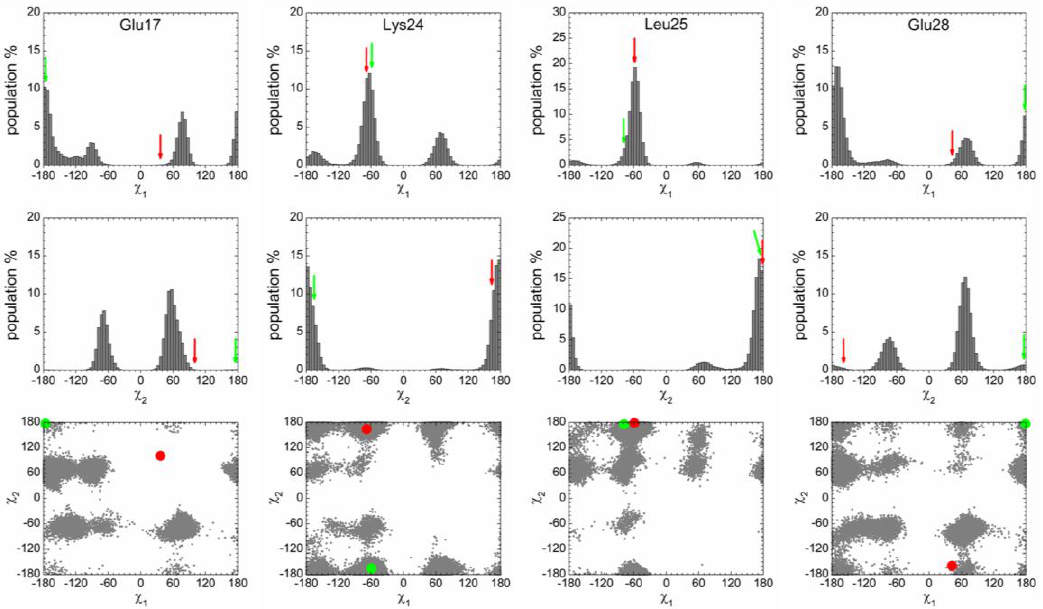
Figure 5. Conformational analysis of non-anchor residues in the helix state. Bound conformations in the p53N-MDM2 and p53N-Taz2 complexes are denoted by red and green markers,